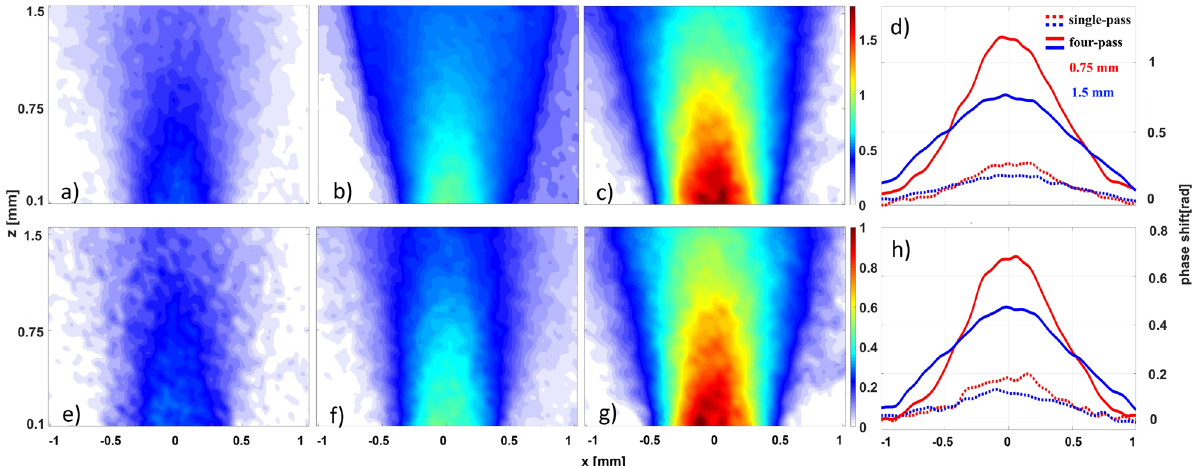
Figure 2. Comparison of spatial phase distributions obtained at a different number of passes of the probe beam through the gas jet generated by a cylindrical nozzle for backing pressure of 1.6 bar Ar ( a – c ) and 7 bar He ( e – g ). For the phase maps from left to right single-pass, double-pass, and four-pass. Phases at two different heights above the nozzle in the single-pass and the four-pass configurations are shown for Ar ( d ) and He ( h ) jets.